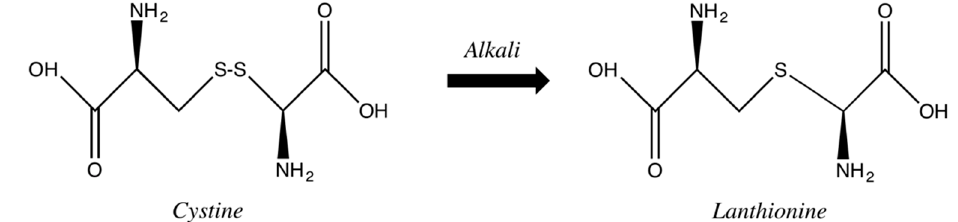
Figure 9. Summarized reaction showing disulfide bond and lanthionine bond before and after alkali